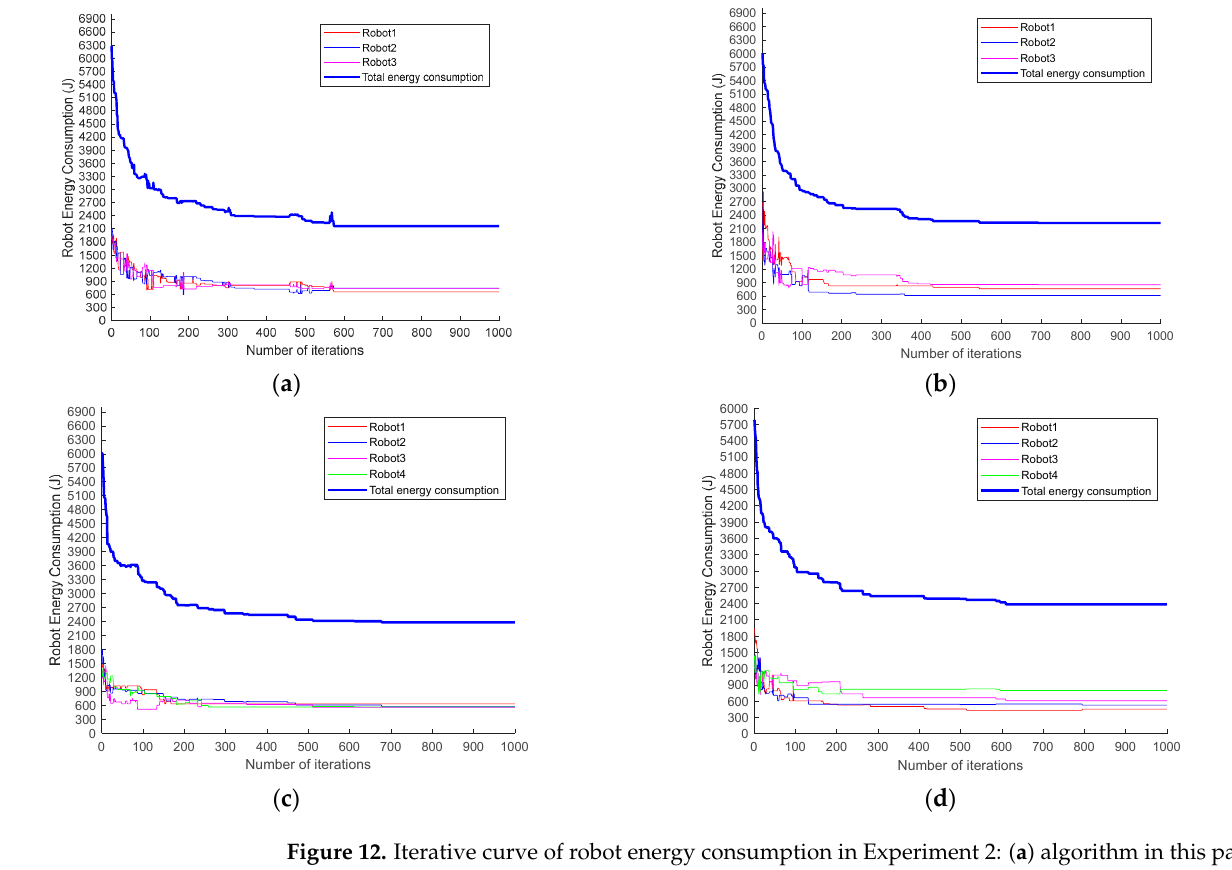
Figure 11. Multirobot optimal task allocation diagram from Experiment 2: ( a ) algorithm in this paper ( m = 40, n = 3); ( b ) basic genetic algorithm ( m = 40, n = 3); ( c ) algorithm in this paper ( m = 40, n = 4); ( d ) basic genetic algorithm ( m = 40, n = 4).